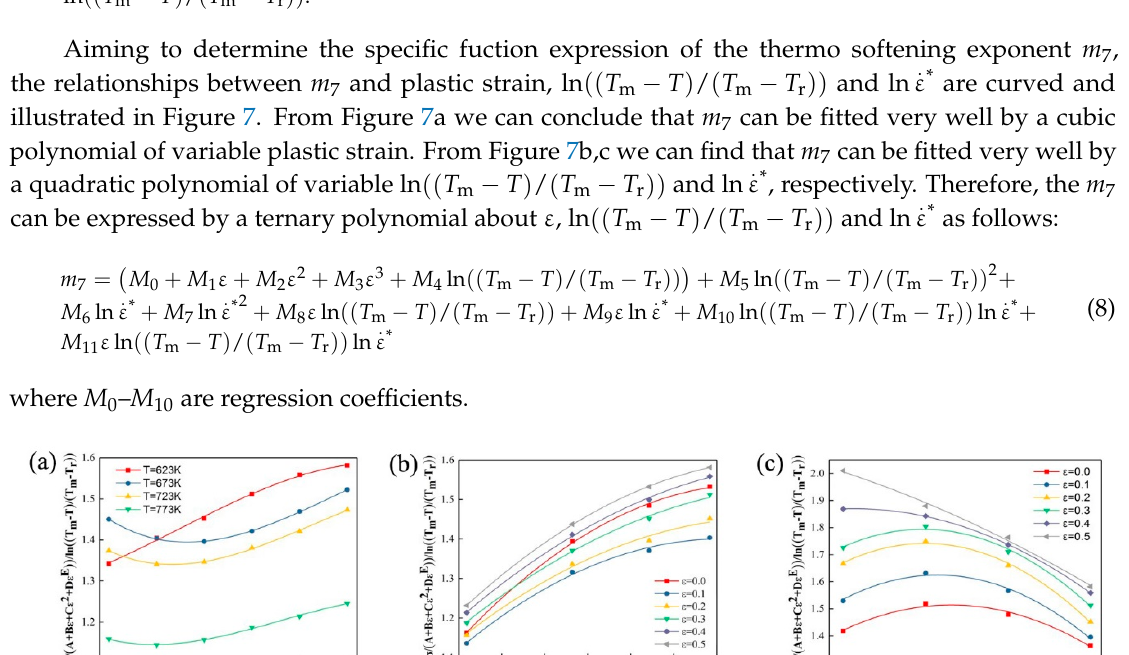
Figure 6. The relationships between ln (( T m − T ) / ( T m − T r )) .